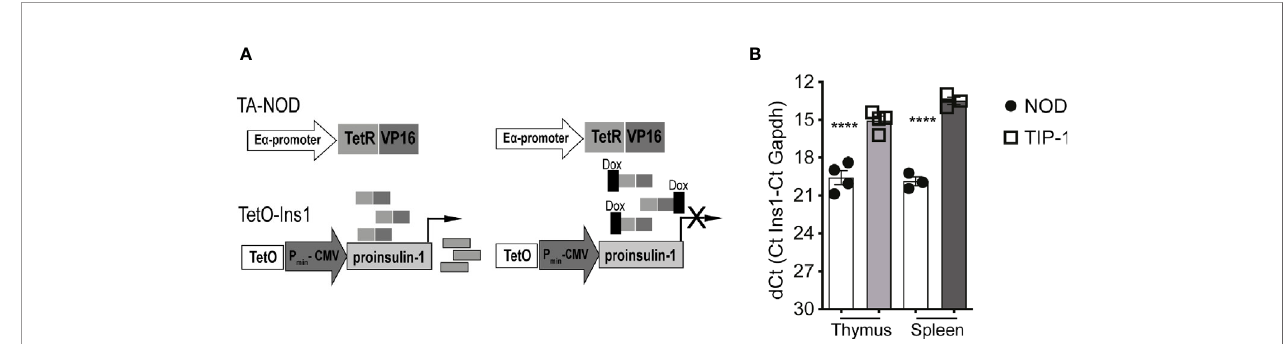
FIGURE 1 | Conditional proinsulin 1 expression in TIP-1 mice (A) Scheme of generation of tetracycline regulated NOD.IE a -tTA (TA-NOD) and tetO-Ins1 dual transgenic mice referred to herein as TIP-1 mice. TA-NOD mice were crossed with tetO-Ins1 mice. Bi-transgenic animals constitutively express PIns1 in APCs (B) Quantitative RT-PCR was performed using Taqman probes for Ins1 and Gapdh in thymic and splenic lysates of WT-NOD mice TIP-1 mice. Data represent dCT values (Mean ± SEM) from 2-3 independent experiments run in duplicate for each probe. ****P < 0.0001. Data compared using One-way ANOVA with Sidak ’ s multiple comparisons